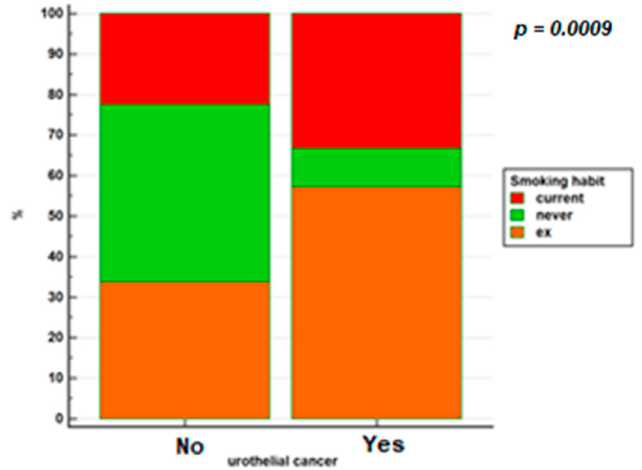
Figure 2. Smoking habits in patients with IBD based on whether or not they have developed urothelial cancer.